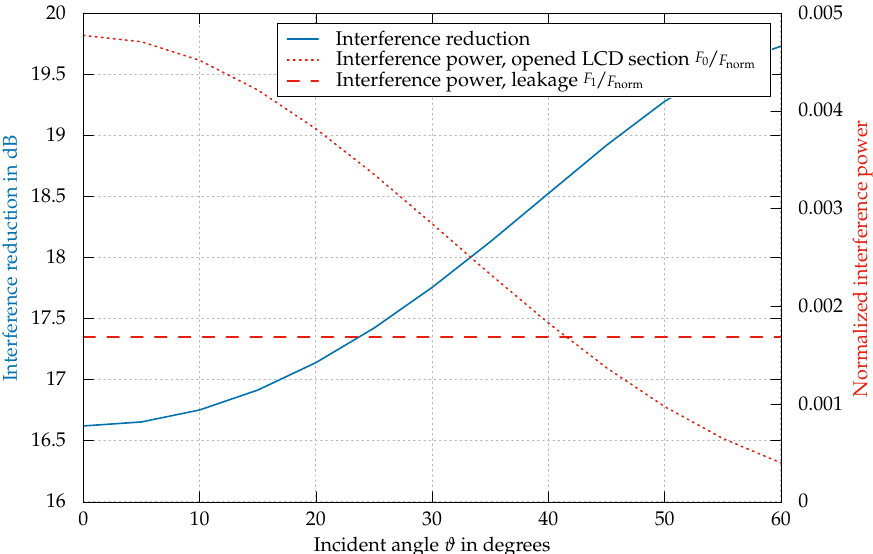
Figure 5. Suppression of unmodulated and diffuse interfering light sources using the method described in Section